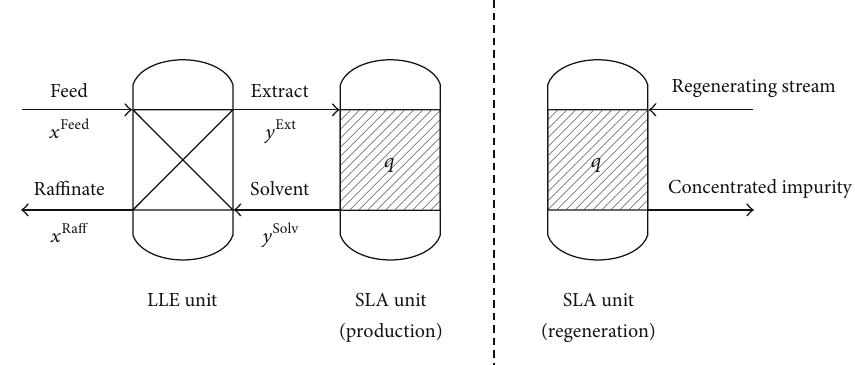
Figure 1: Scheme of liquid-liquid extraction (LLE) unit coupled to solid-liquid adsorption (SLA) unit.